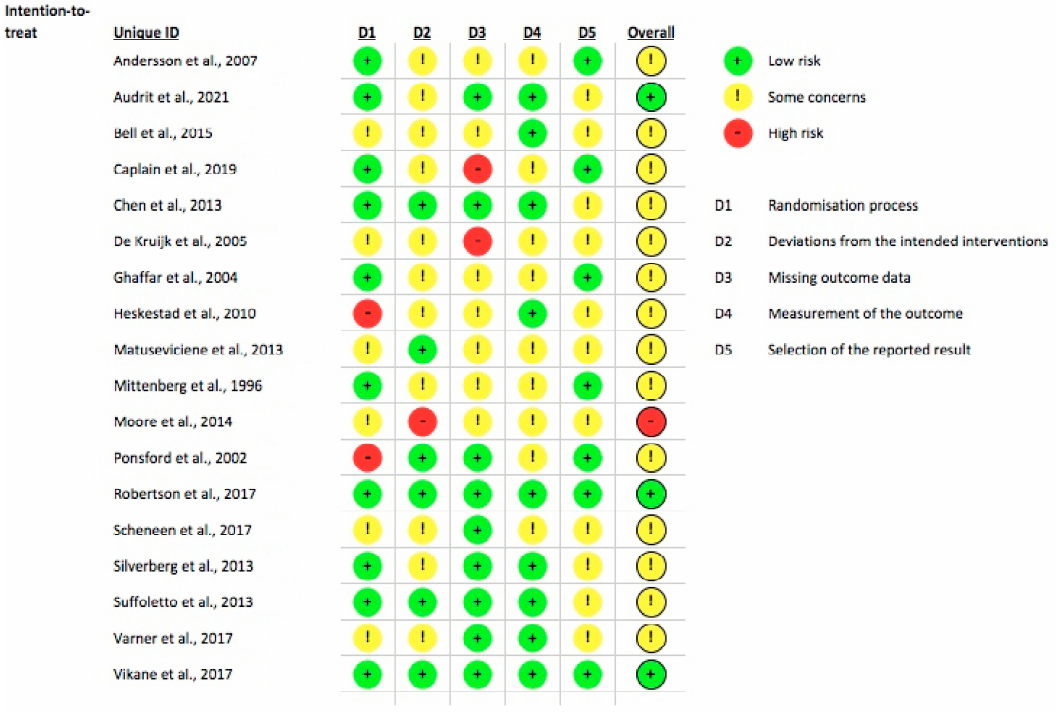
Figure A4. Risk of Bias for each study included in the Section 3.4, assessed using the Cochrane Rob2 tool revised version [56–73].